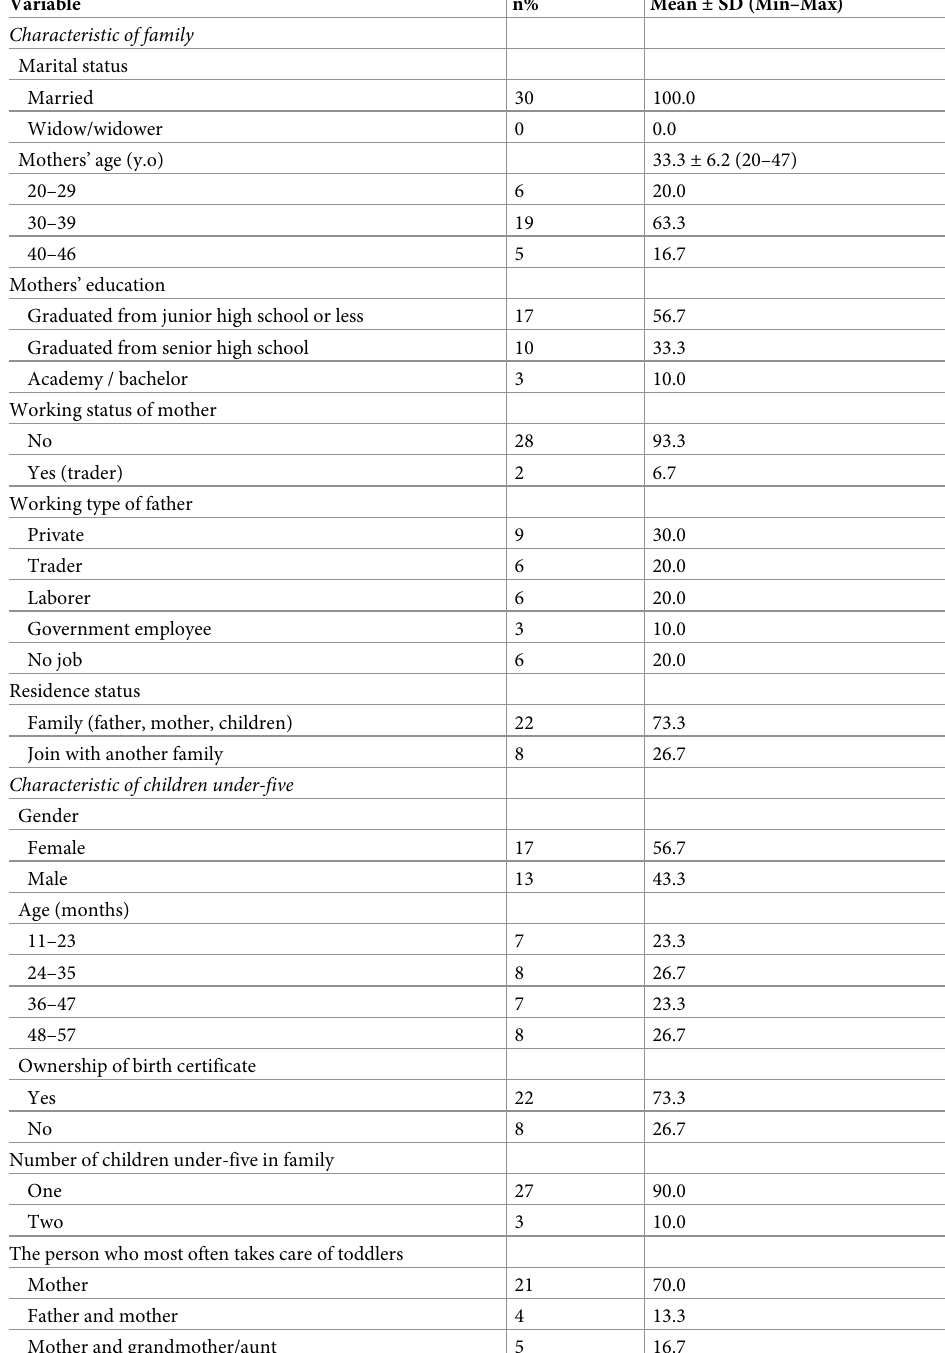
Table 2. Socio-demography and anthropometry characteristic of